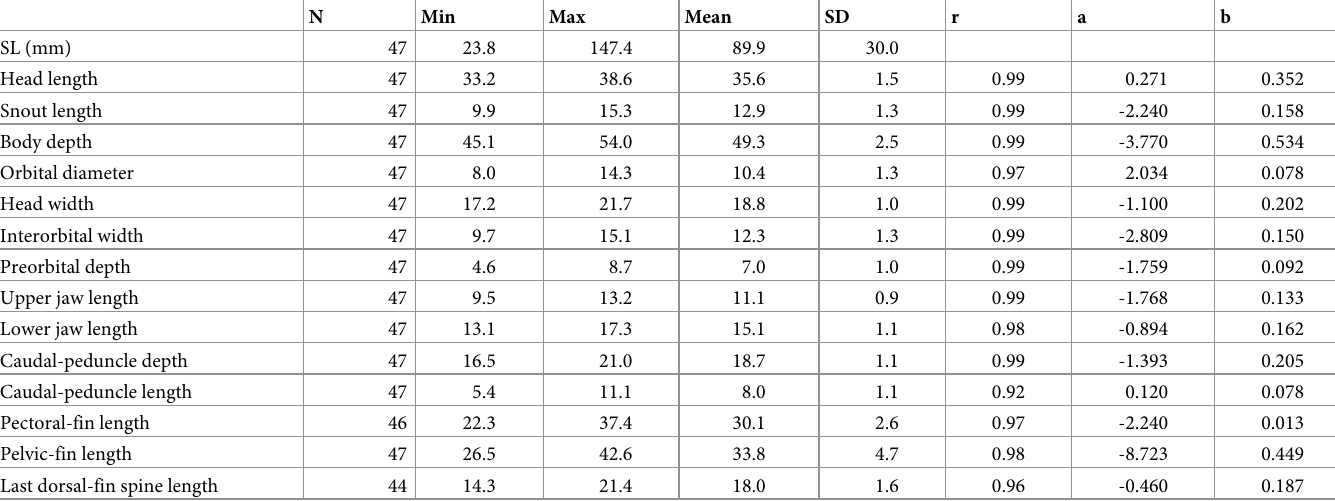
Table 10. Australoheros facetus . Proportional measurements (per cent of SL) and linear regression parameters. N